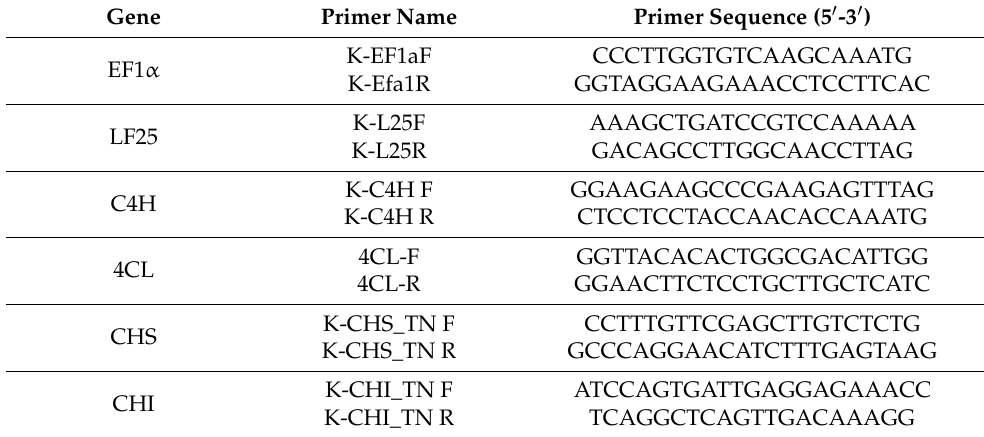
Table 3. qPCR primer pairs for flavonoid-related